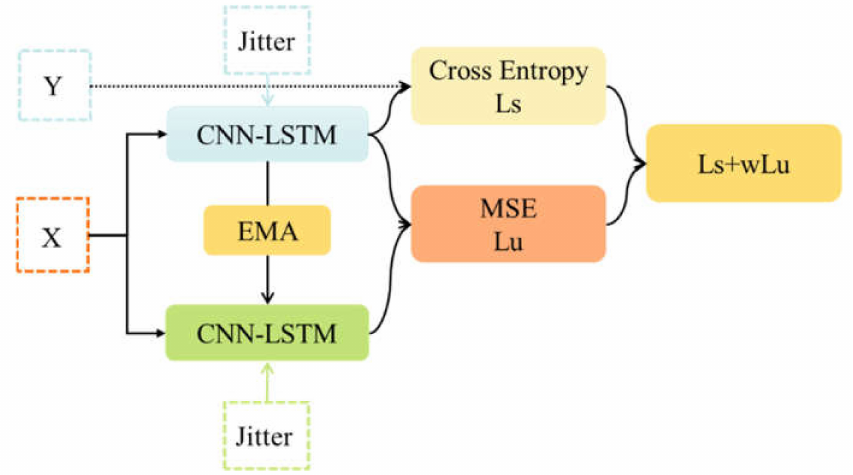
Figure 6. Mean Teacher overall frame diagram.